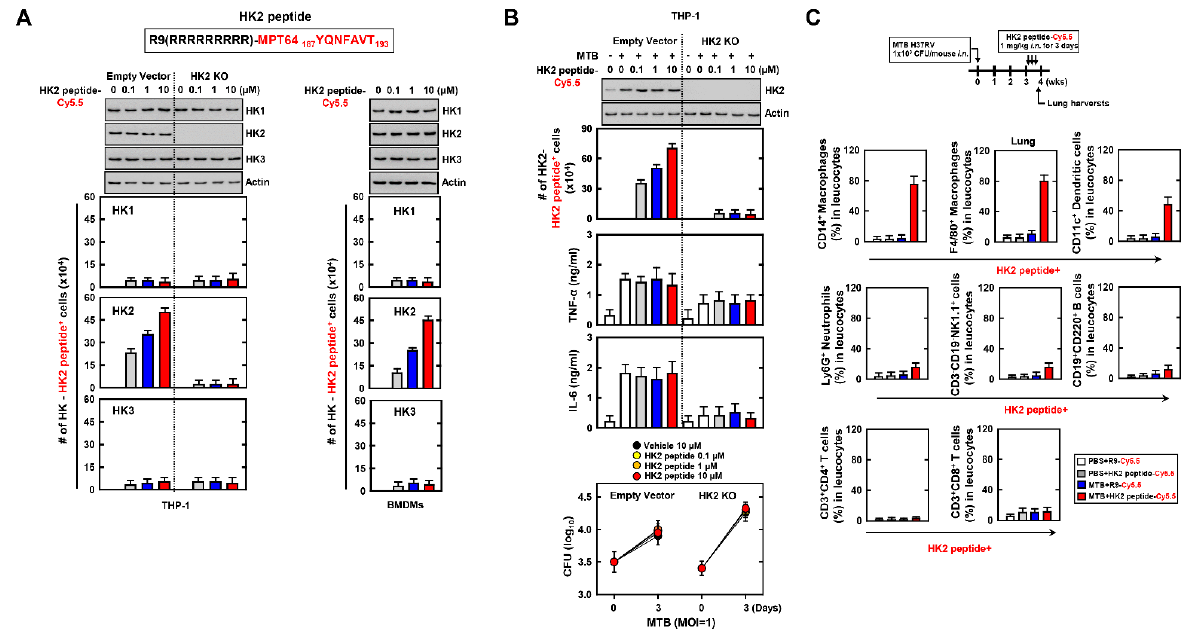
Figure 5. HK2 peptide’s role in signal peptide for targeting the MTB-infected macrophages. ( A ) Schematic design of HK2 peptide (upper). Empty or HK2 KO THP-1 and BMDM cells were treated with Cy5.5 labelled-HK2 peptide for 1 h in